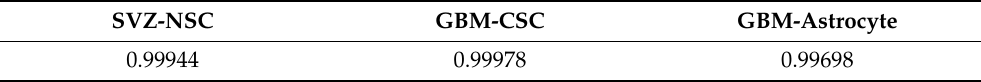
Table 2. Fitting correlation factor R 2 for the different glioblastoma cells.